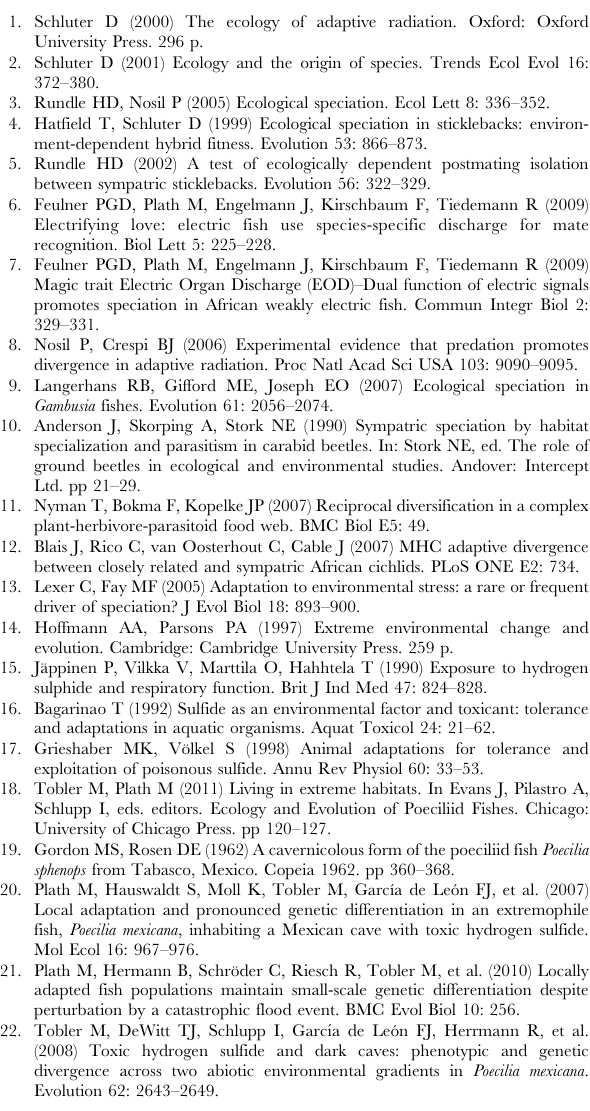
Figure S1 Lip protuberances of the sulphur molly ( P. sulphuraria ). Female, dorsal view. Arrows indicate lip protu- berances. Scale bar = 1 mm.